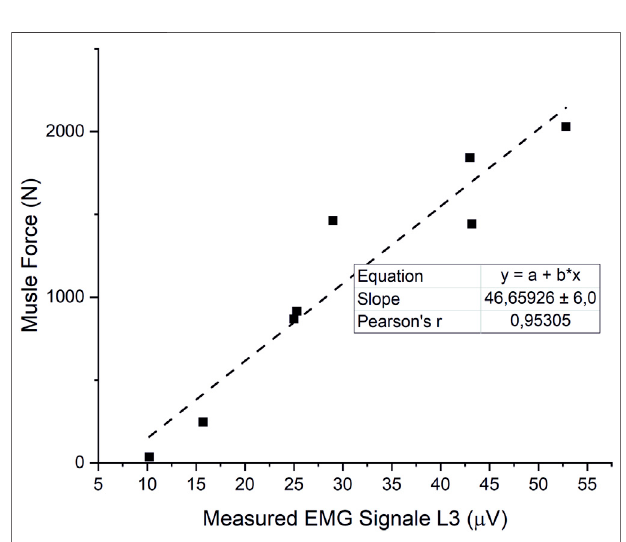
FIGURE 8 | Correlation of estimated ES forces and measured EMG signals from (Takahashi et al., 2006).